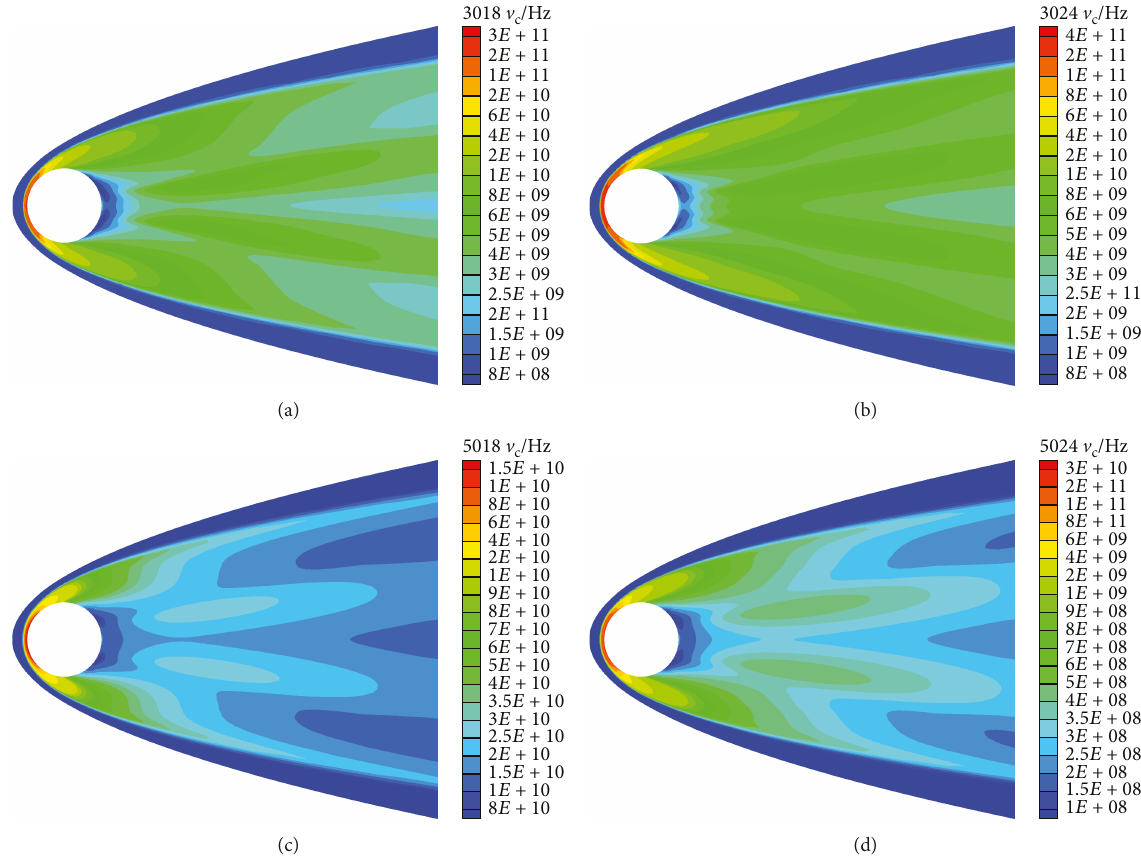
ff erent fl ight conditions for a hypersonic sphere. (a) h = 30 km, Ma = 18 ; (b) h = 30 km, Figure 6: Distributions of collision frequency ν c at di Ma = 24 ; (c) h = 50 km, Ma = 18 ; (d) h = 50 km, Ma = 24